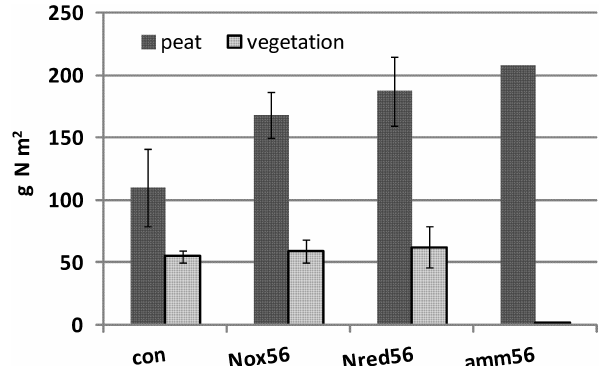
Fig. 7. Immobilization of N above and below ground, in the peat from the control (no added N) and N treated (oxidised (Nox), re- duced (Nred) and ammonia (amm)) plots ( ∼ 56kgNha − 1 yr − 1 ) at Whim bog in